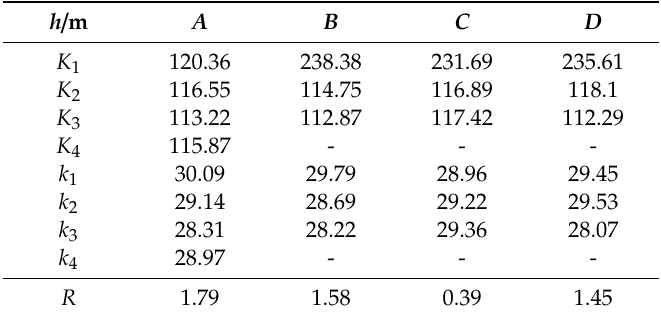
Table 14. 1.4 Q head analysis.